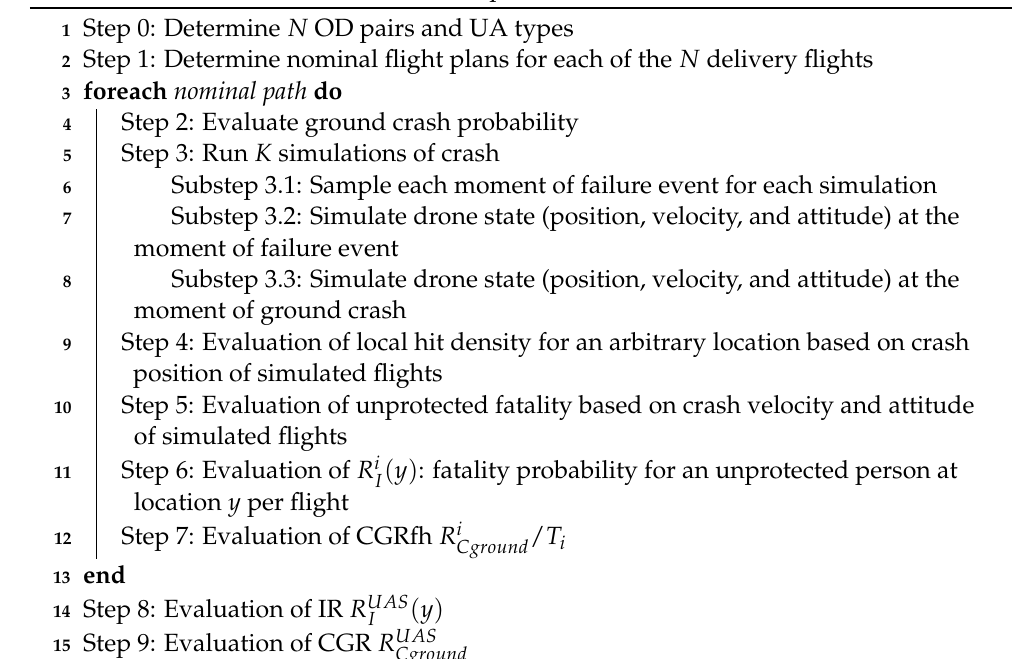
Algorithm 1: Monte Carlo simulation-based evaluation of annual Third-Party Risk indicators for a commercial UAS operation